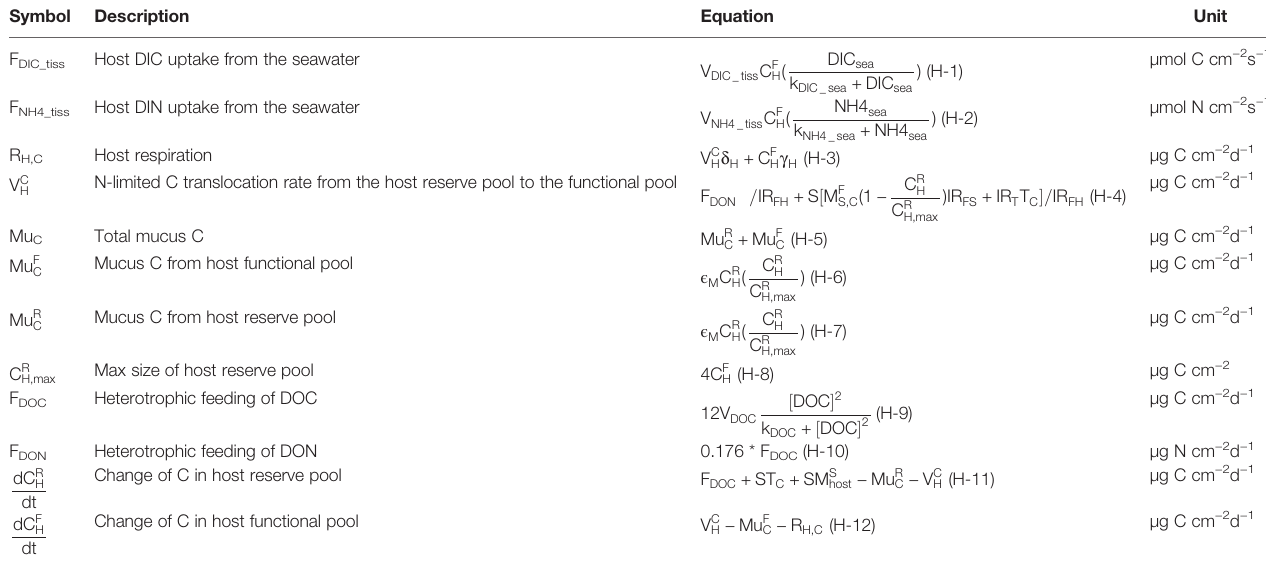
TABLE 4 | Model equations for coral